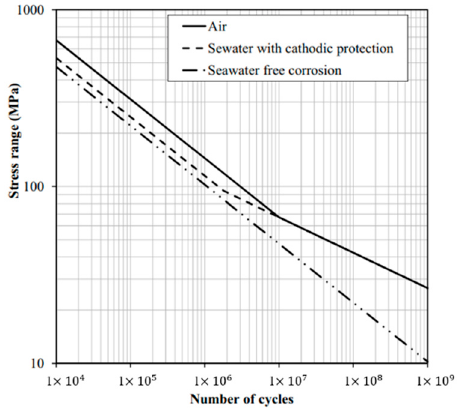
Table 1. S–N curve parameters of tubular joints in a seawater environment.